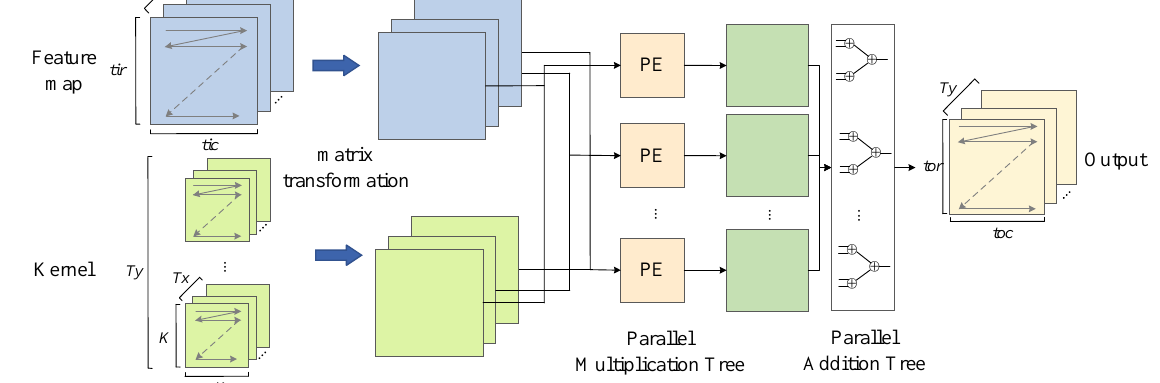
Figure 14. Architecture of the convolution module based on the Winograd